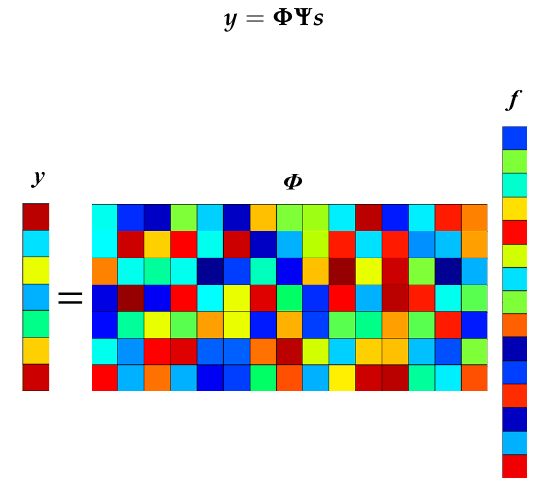
Figure 1. Incomplete sampling of signal f.